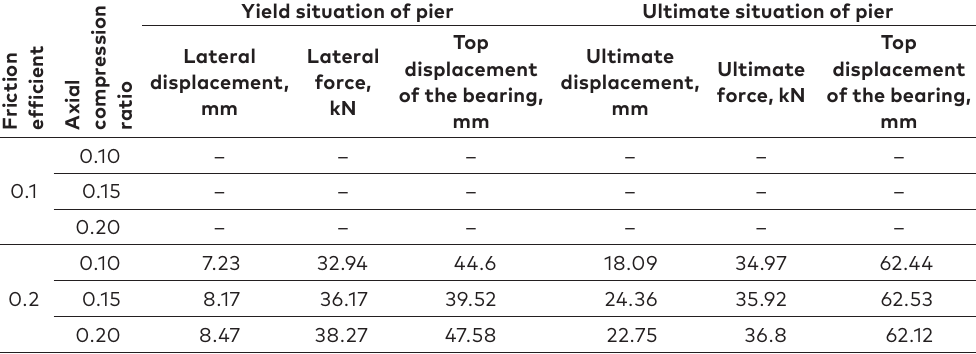
Table 3. Horizontal force of the series system under